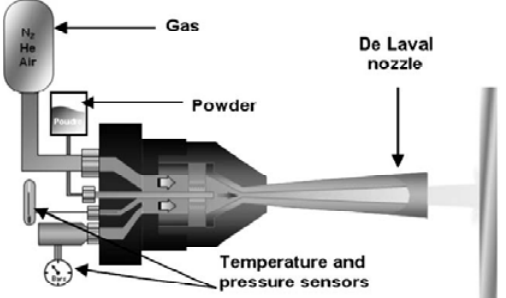
Figure 1: The schematic drawing of cold gas spray apparatuses